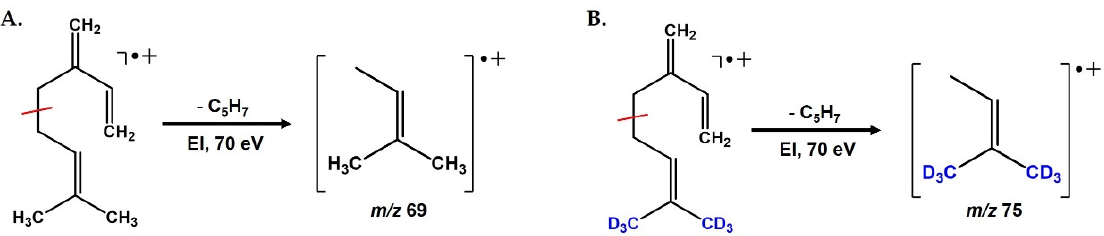
Figure 2. The electron ionization fragmentation observed for the molecular ions of β -myrcene ( A ) and β -myrcene-d6 ( B ).